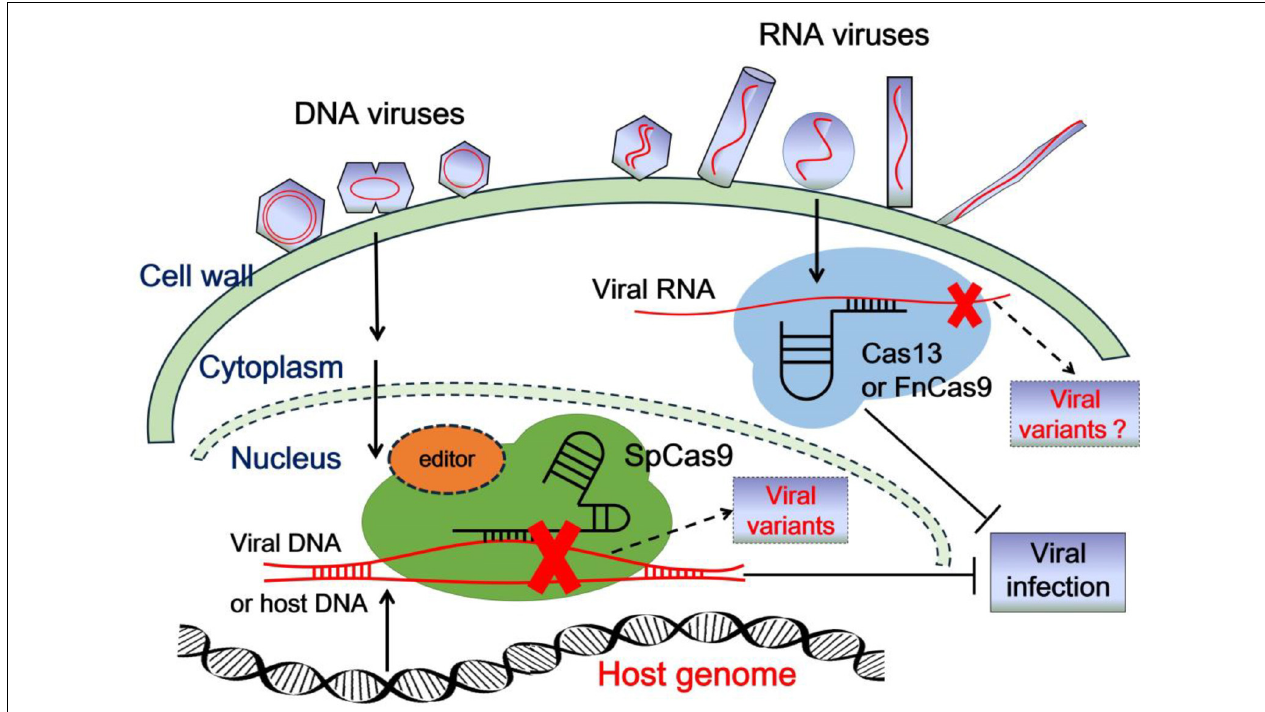
FIGURE 1 | Schematic representation of class 2 CRISPR/Cas systems to confer resistance to plant viruses. After plant viruses enter into plant cells, the viral genome is uncoated and transcribed, or translated with the help of host factors. Plant viruses then multiply their genome in the nucleus or in the cytoplasm. The viral genome DNA or RNA can be targeted, destroyed, or interfered with by CRISPR/Cas9 or CRISPR/Cas13 (or FnCas9) systems in the nucleus or in the cytoplasm, respectively, which inhibits viral infection. In addition, the mutation or deficiency in host susceptibility factors edited by the CRISPR/Cas9 system also perturbs viral infection. However, some new viral variants might be generated as by-products when CRISPR/Cas systems edit the viral genome, which might drive the risk of viral